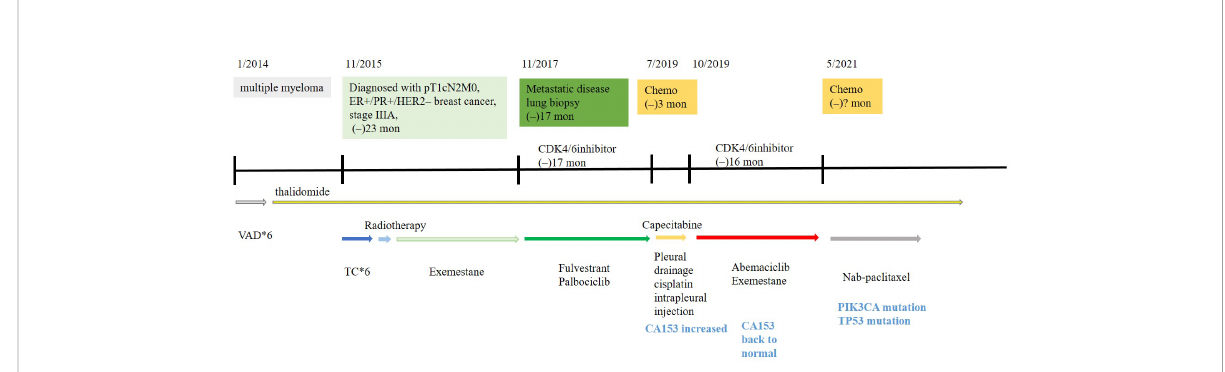
FIGURE 1 Treatment history of this HR+/HER2 − breast cancer patient receiving abemaciclib combined with exemestane after prior progression on palbociclib and